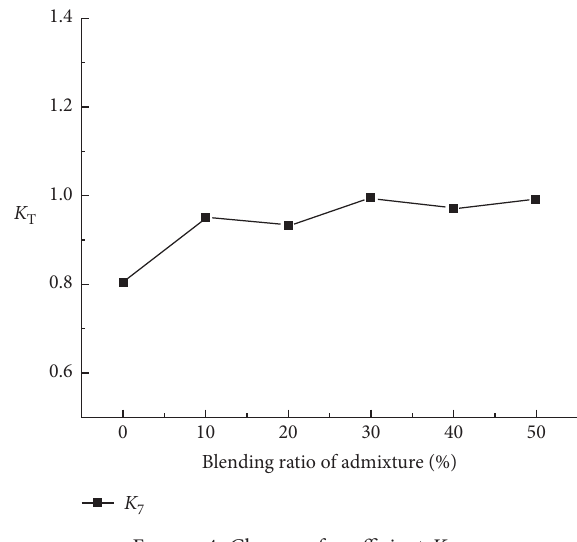
Figure 4: Change of coefficient K